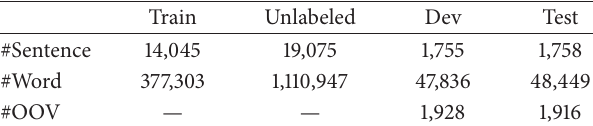
Table 4: The statistics summary of data in TCT.